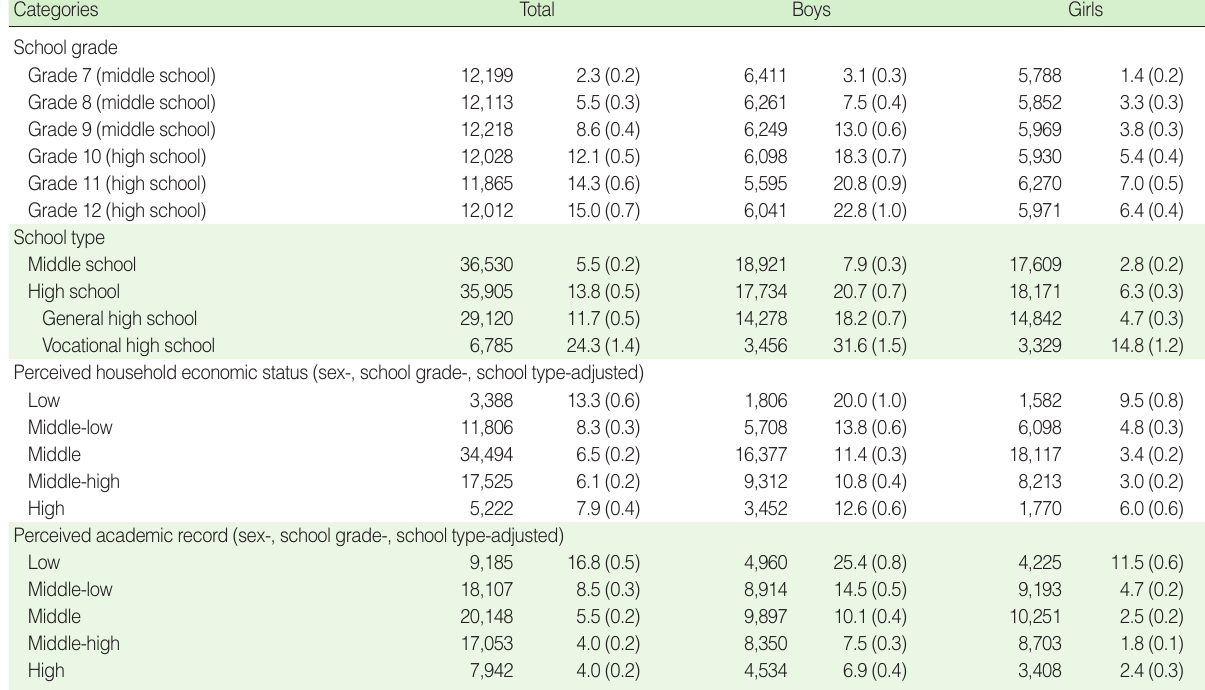
Table 2. Prevalence of current cigarette smoking 1 among adolescents in the Korea Youth Risk Behavior Web-based Survey,